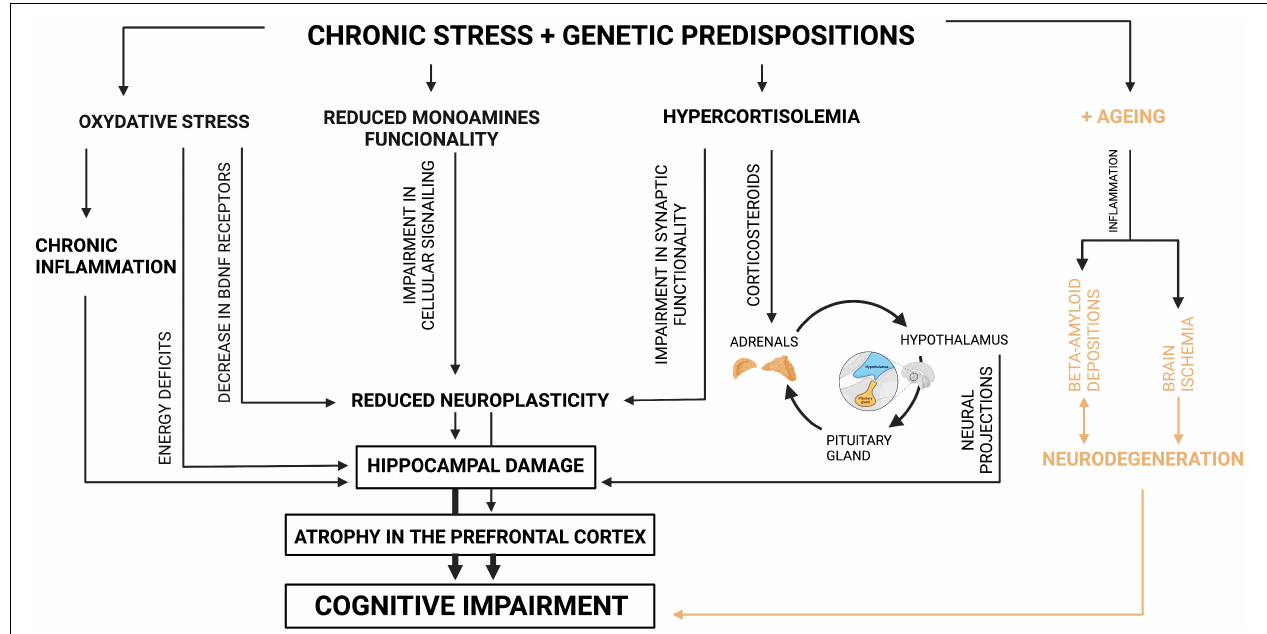
FIGURE 1 | Mechanisms of cognitive impairment in depression. Source: authors; created in BioRender.com. Genetically predisposed individuals who are exposed to negative environmental factors, which induce depression, present a variety of changes in their organisms. A basic defensive reaction for environmental stress is oxidative stress, which results in energy deficits on the level of the cell. Particularly sensitive cells are the cells of the hippocampus; therefore its damage occurs as the consequence. Moreover, oxidative stress leads to decrease in the number of BDNF receptors, which manifests itself in reduced neuroplasticity. Oxidative stress also triggers inflammation, which as well results in damage in the hippocampus. Another reaction for chronic stress among genetically predisposed individuals is reduced monoamines functionality which by impairment in cellular signaling leads to reduced neuroplasticity. The next parallel reaction for chronic stress, possible because of specific genes, is hypercortisolemia. This one, when it is chronic, results in disturbance in the HPA axis. Due to the fact that the HPA axis functions in the feedback loop with the hippocampus, its disturbance leads to the hippocampus damage. Moreover, the increased level of glucocorticoids impairs synaptic functionality, which is manifested by reduction in neuroplasticity. In general, when neuroplasticity is affected, the hippocampus and prefrontal cortex present shrunk neurons, which leads to atrophy or even damage of the tissues. Due to the fact that these structures are mainly responsible for cognitive performance, their functional alterations result in cognitive impairment. Additionally, the elderly who are genetically predisposed and affected by environmental factors present brain ischemia derived from cardio-vascular problems and beta-amyloid depositions. Both pathomechanisms also manifest themself as cognitive